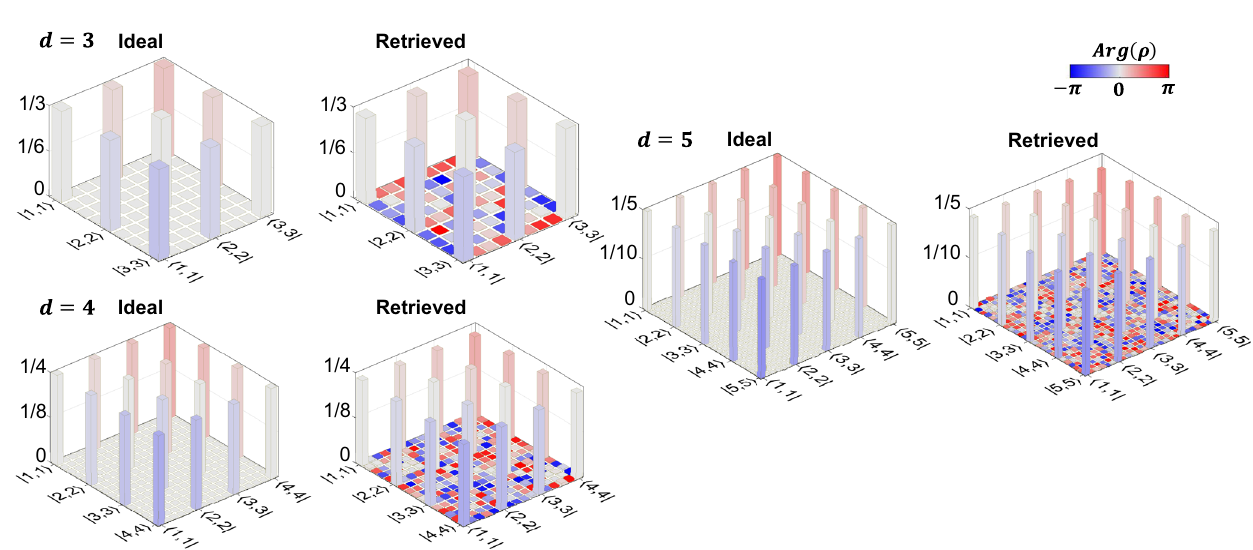
Fig.3|FinalestimatedstatesforthePPLNBFCand R =21measurements. Idealandretrieveddensitymatricesfor d ∈ {3,4,5}.Idealstatesare d -dimensionalBellstates with additional spectral phase equivalent to 20m of single-mode fi